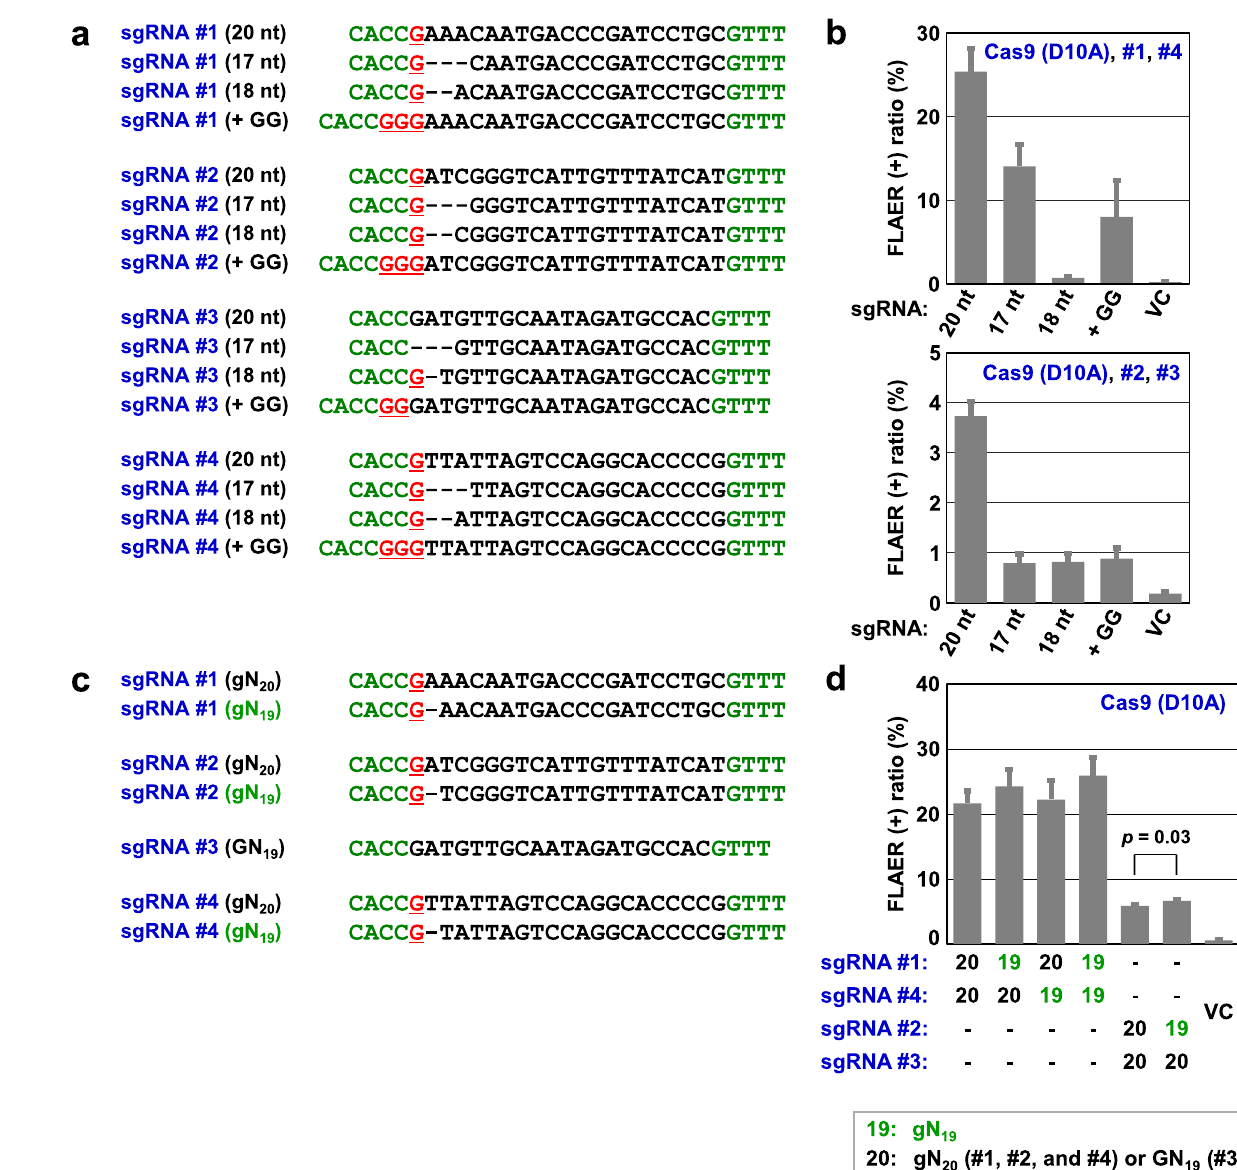
Figure 6. The use of spacers exactly 20 bp in length supports efficient targeted knock-in via TPN. The HCT116- mut PIGA clone was transfected with Donor- PIGA (1991 bp) along with tandem-paired Cas9 nickases loaded with various sgRNAs. (a,c) Lists of spacer sequences incorporated into PX462. “CACC” and “GTTT” located at the 5 ′ and 3 ′ ends of each sequence, respectively, are cohesive overhangs for ligation of DNA fragments. Underlined Gs indicate artificially integrated deoxyguanosines that are not present at the corresponding positions in the genome. (b,d) Graphical representation of data acquired by FCM analyses using sgRNAs that contain spacers listed in ( a,c ). Data represent the mean and SEM values of three independent